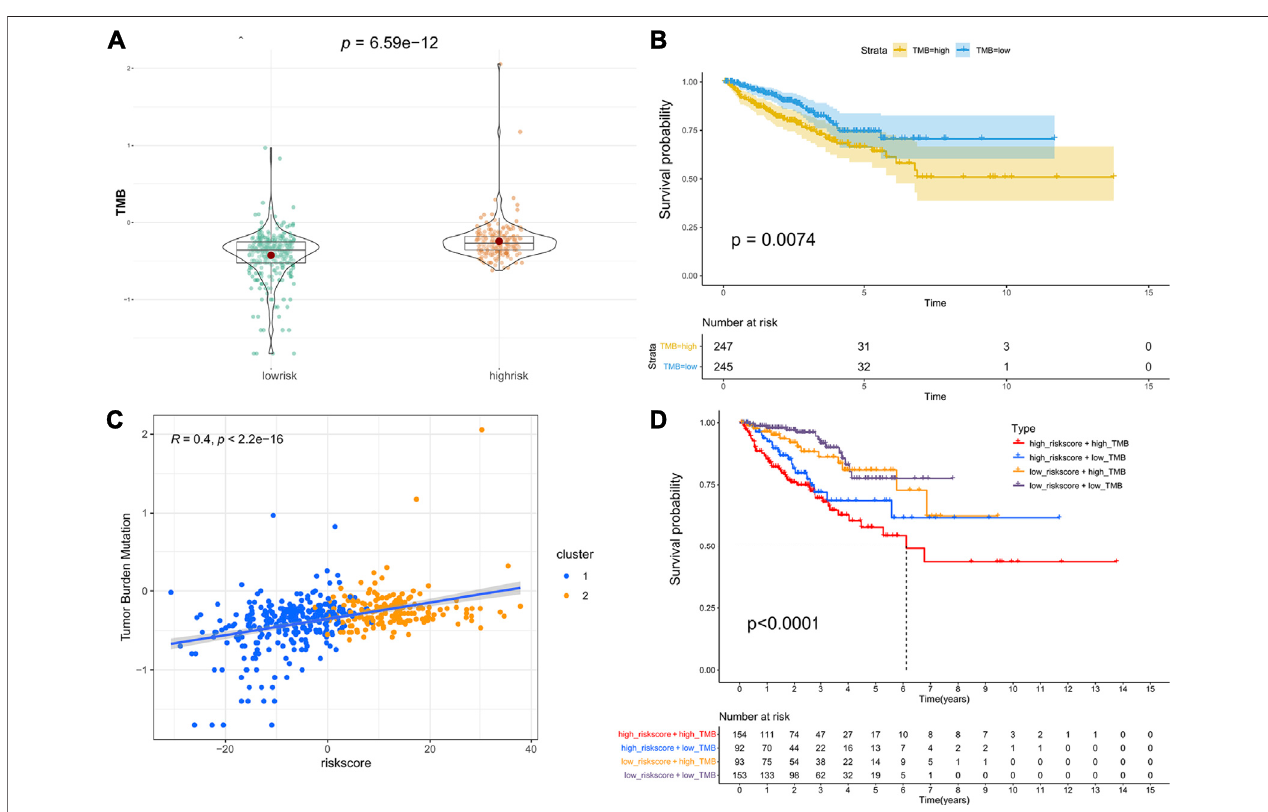
FIGURE 6 | Association between riskscore and TMB: (A) The difference in TMB between the high- and low-risk groups. (B) Kaplan – Meier survival curves of PFS between the high- and low-TMB groups. (C) The correlation of riskscore and TMB. (D) Kaplan – Meier survival curves of PFS among the four subgroups strati fi ed by riskscore and